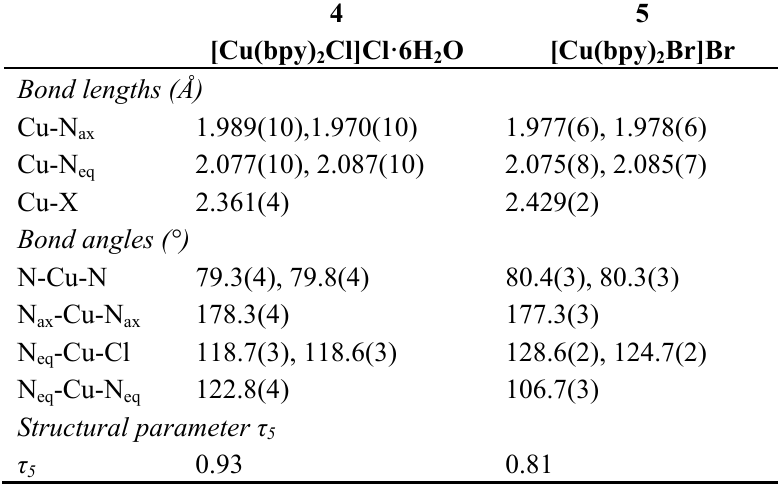
Table 3. Key geometric parameters of 4 [35] and 5